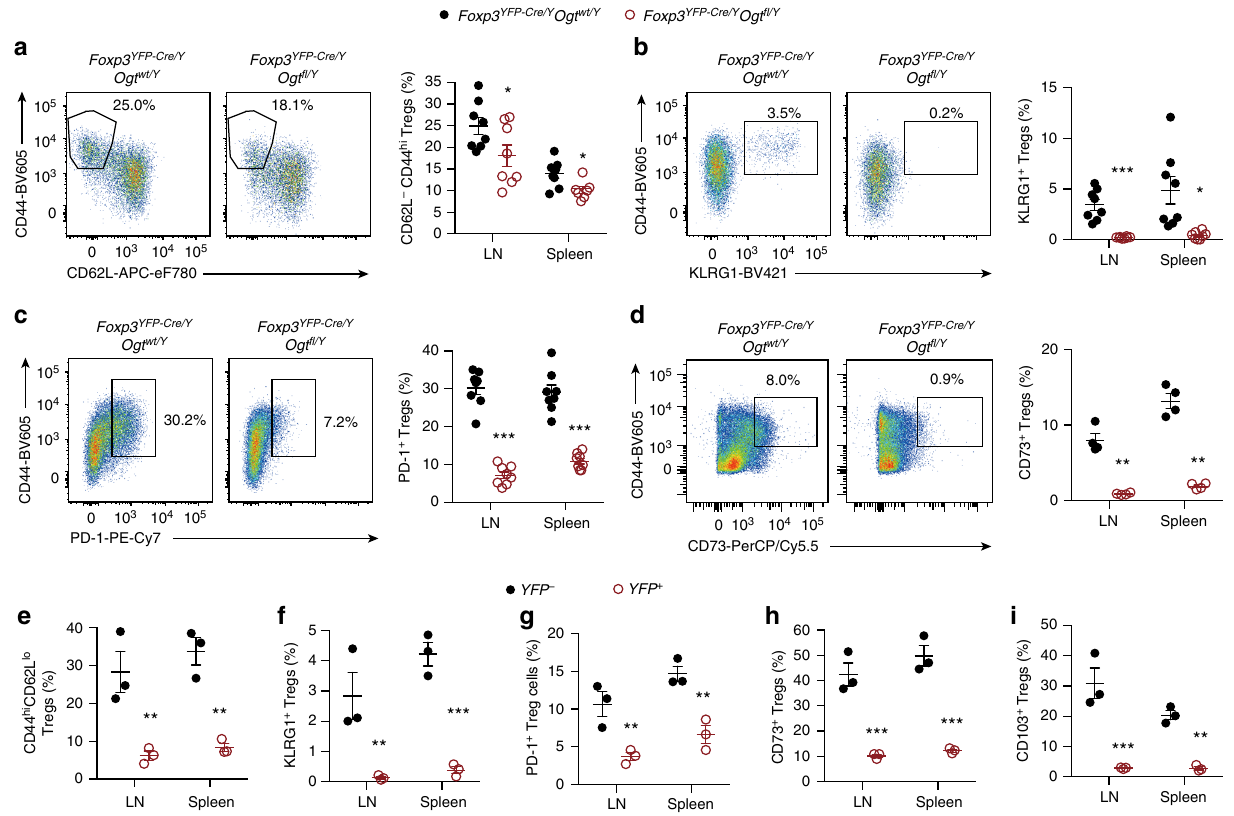
Fig. 5 O-GlcNAcylation is required for the effector differentiation of Treg cells. a – d Frequencies of CD44 hi CD62L lo ( a ), CD44 + KLRG1 + ( b ), CD44 + PD-1 + ( c ), and CD44 + CD73 + ( d ) cells among YFP + CD25 + Treg cells in the LNs and spleen from 2-week-old Foxp3 YFP-Cre/Y Ogt wt/Y and Foxp3 YFP-Cre/Y Ogt fl /Y mice, at least n = 4 each group. e – i Frequencies of indicated cell populations among YFP − OGT-suf fi cient and YFP + OGT-de fi cient CD4 + TCR β + CD25 + GITR + Treg cells in the LNs and spleen from Foxp3 YFP-Cre/wt Ogt fl / fl mice, n = 3 each group. Data are shown as mean ± s.e.m. * p < 0.05; ** p < 0.01; *** p < 0.001 by unpaired student ’ s t